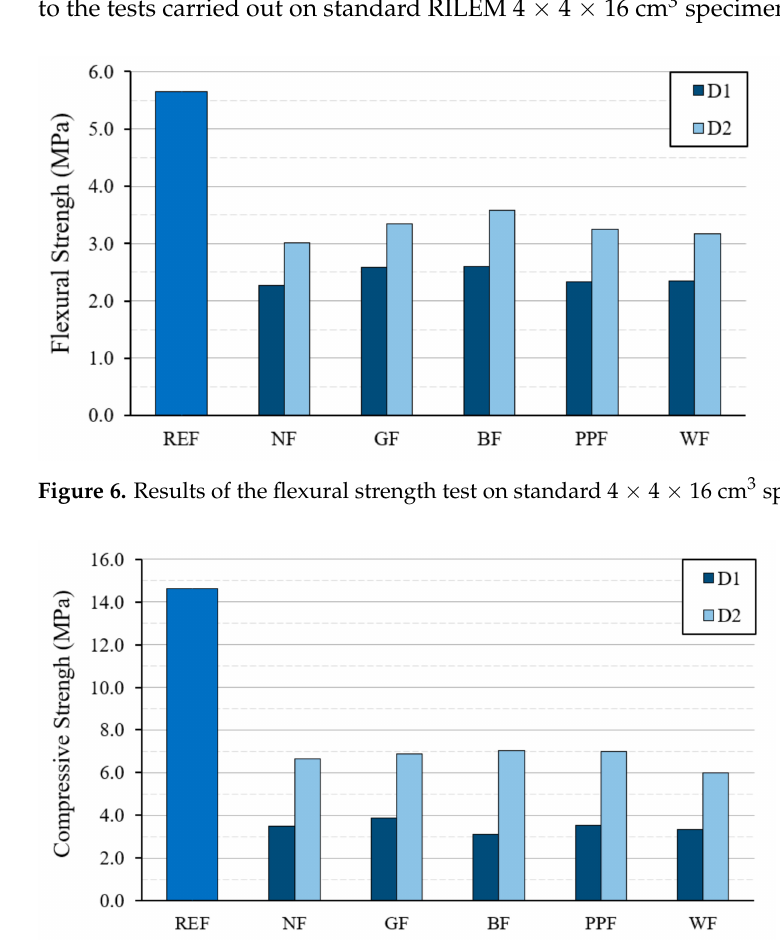
Figure 7. Results of the compressive strength test on standard 4 × 4 × 16 cm 3